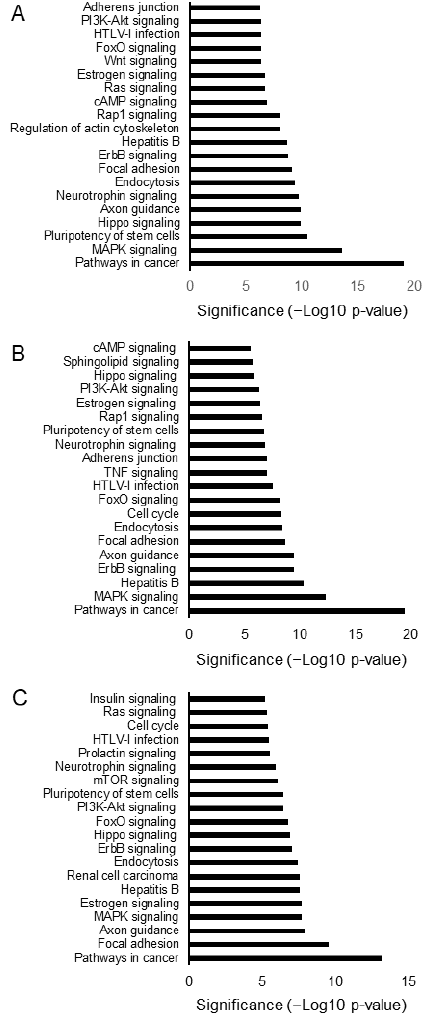
Figure 5. Biological pathways potentially affected by a miRNA-based mechanism. The whole targetomes (predicted and validated) of microRNAs deregulated by cannabisin B ( A ), N - trans - caffeoyltyramine ( B ), and cannabidiolic acid ( C ) were analyzed by the program DAVID and the top-20 significantly enriched KEGG pathways were displayed. Biological pathways were considered statistically significant if p -value was less than 0.05 (Benjamini-Hochberg procedure for multiple